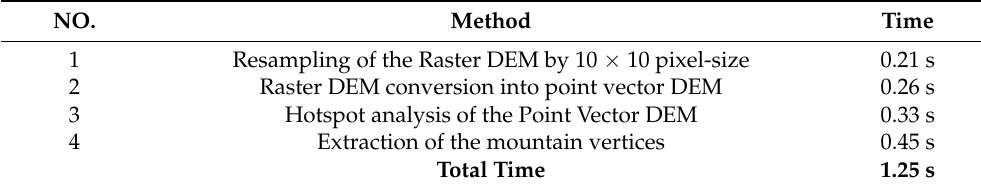
Table 11. The time consumed in extracting mountain vertices for the third dataset using our pro- posed approach.